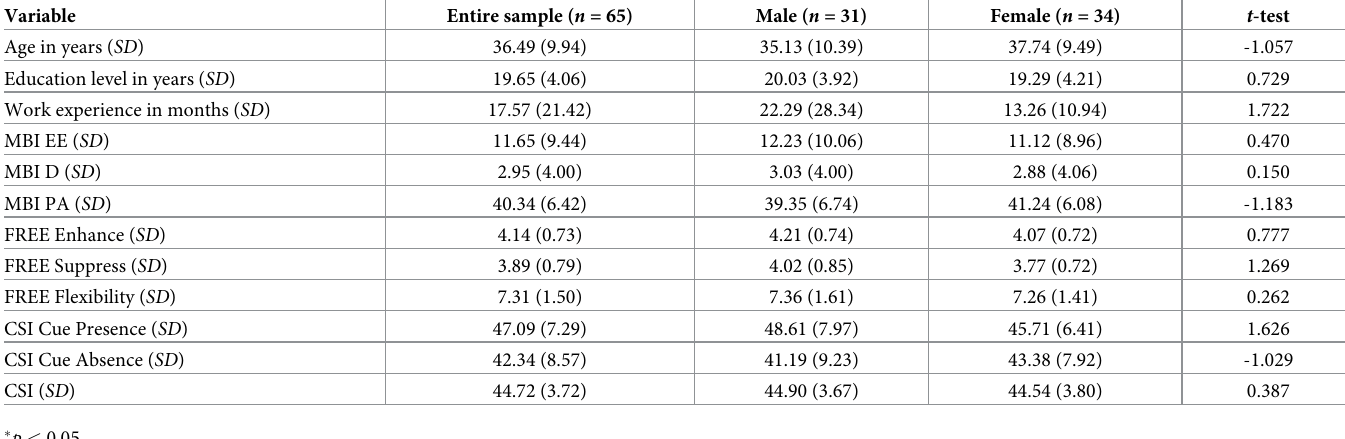
Table 1. Demographic characteristics; work experience; and MBI, FREE, and CSI scores of the participants by gender.